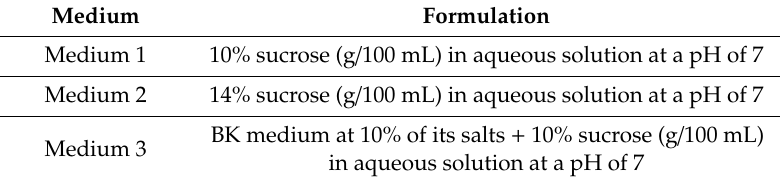
Table 1. Culture media used for the in vitro germination of pollen previously dehydrated in silica gel for 2 h.